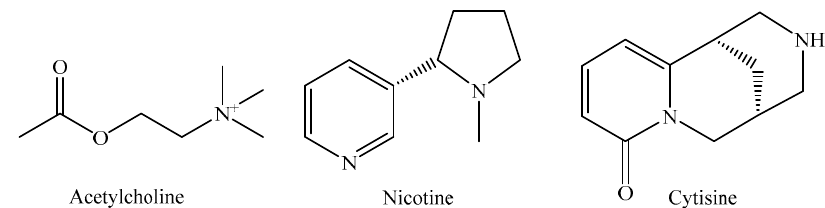
Figure 1. Classical nAChRs agonists.